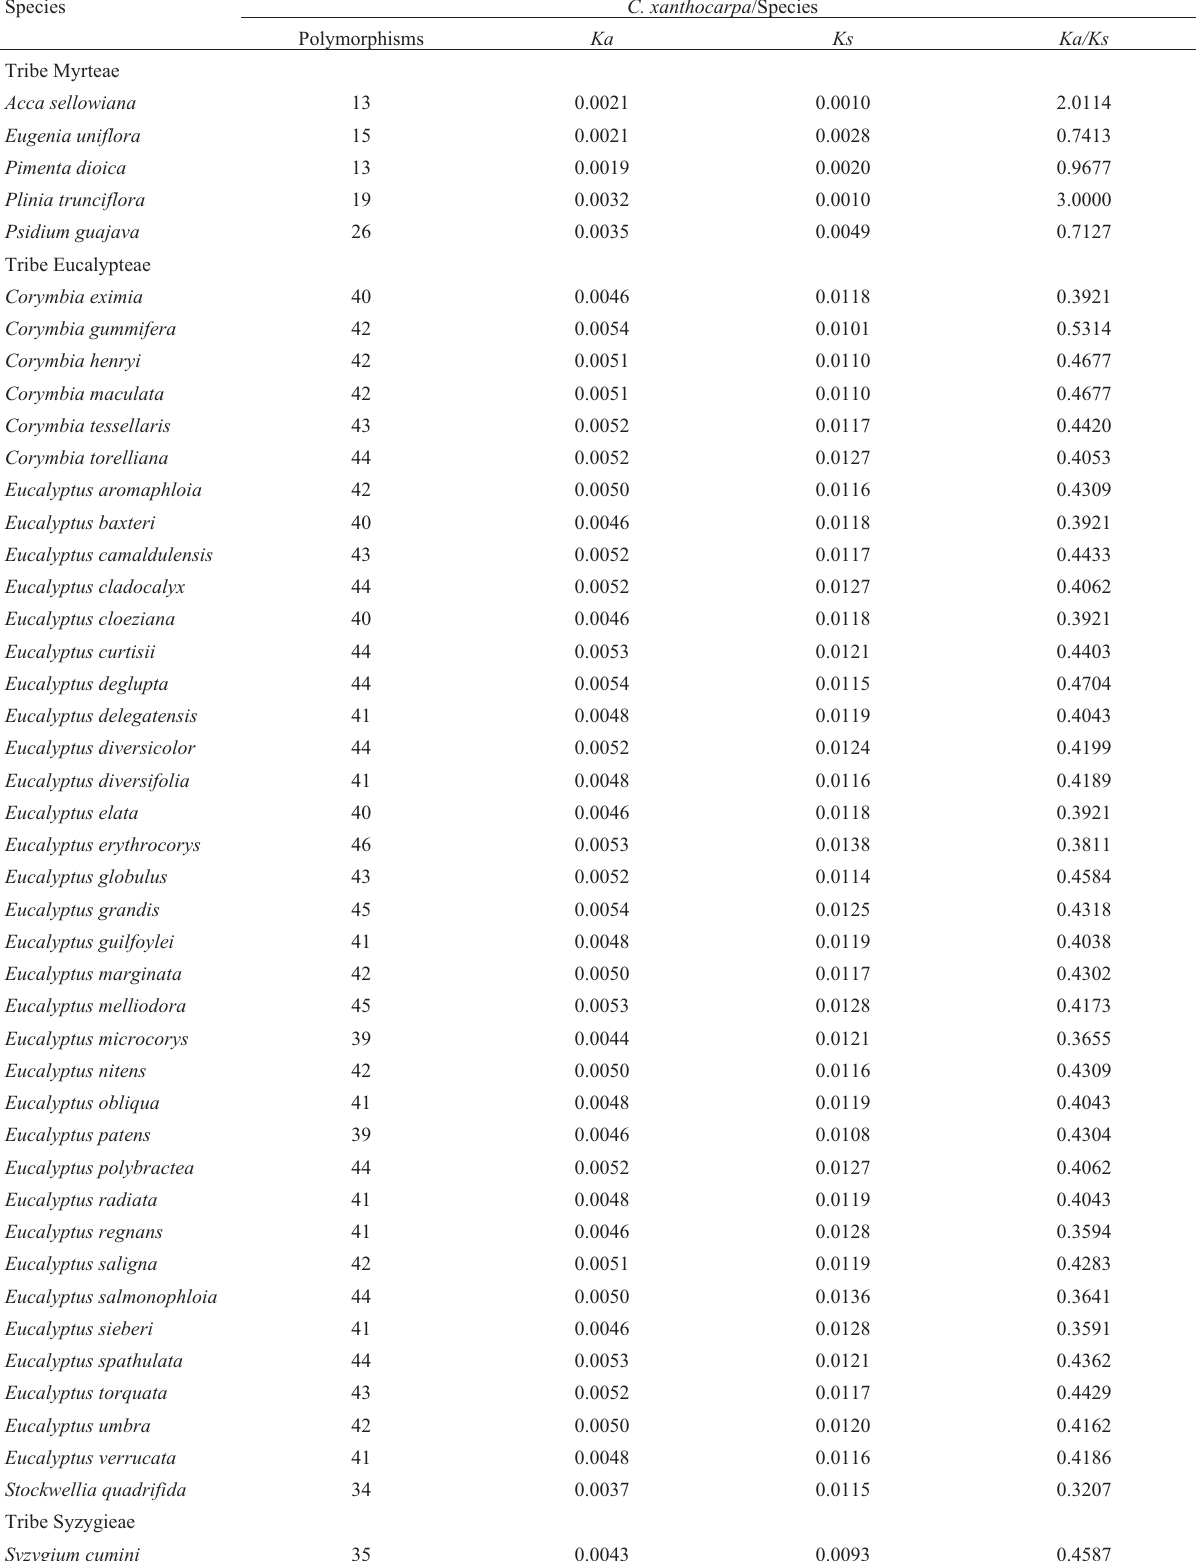
Table 4 - Comparison of polymorphisms (segregating sites), nonsynonymous ( Ka ) and synonymous ( Ks ) substitution rates and Ka/Ks ratio of the ycf2 gene among Campomanesia xanthocarpa and 46 species of